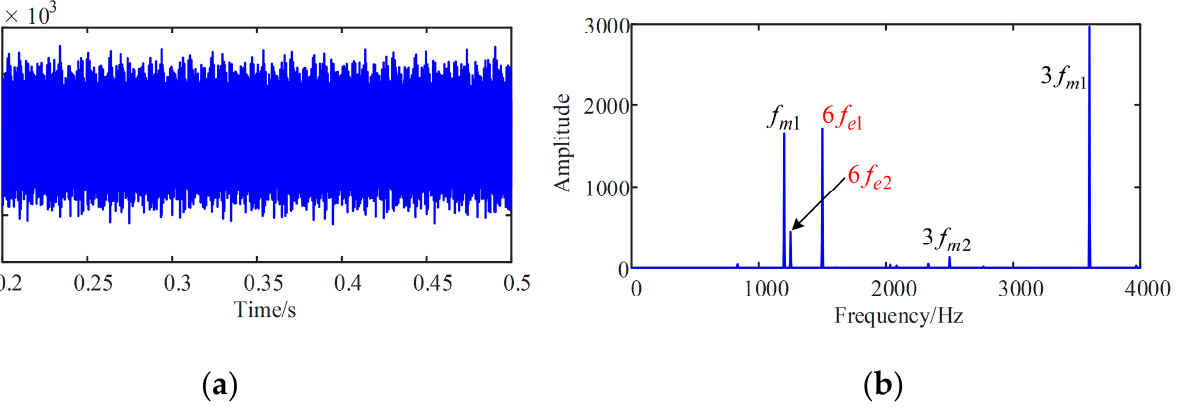
Figure 14. The meshing force of the first gear pair in the dual-motor drive mode: ( a ) time domain; ( b ) PSD.